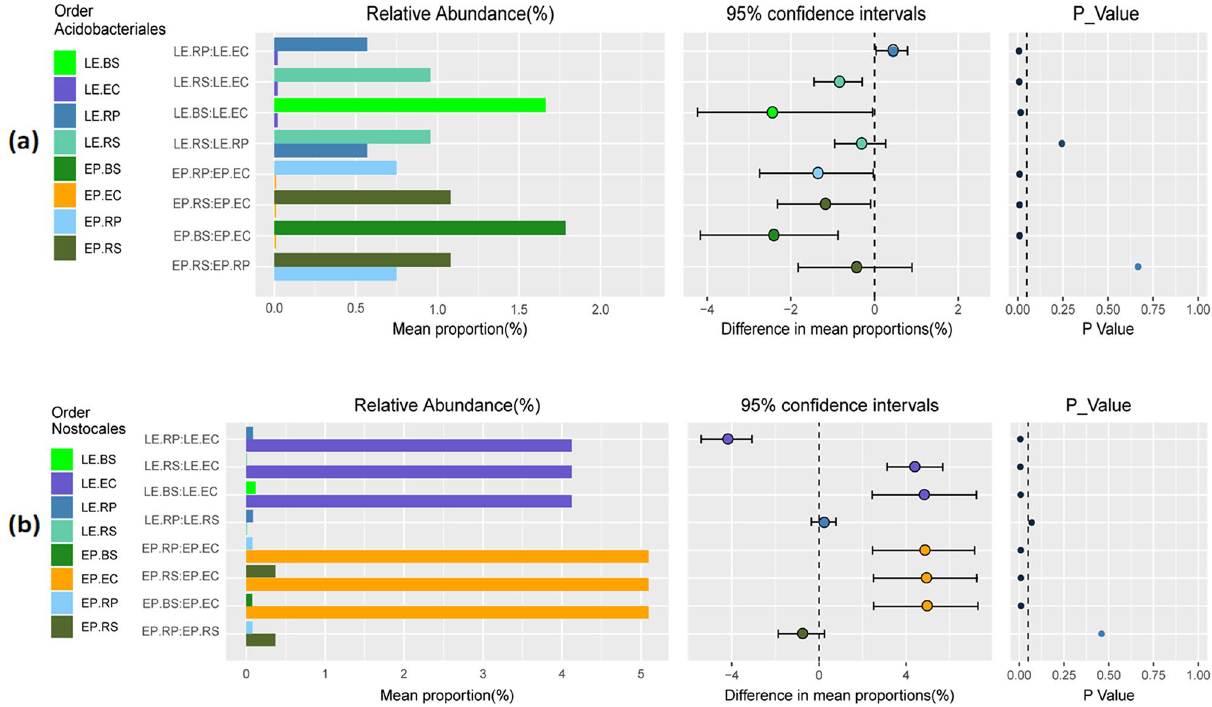
Figure 6. Kruskul-Wallis test using relative abundance of microbes at order level; (a) Acidobacteriales; (b) Nostocales residing endophytic compartment (EC), rhizoplane (RP), rhizosphere (RS), and bulk soil compartments of E. plantagineum (EP), and L. erythrorhizon (LE) plant